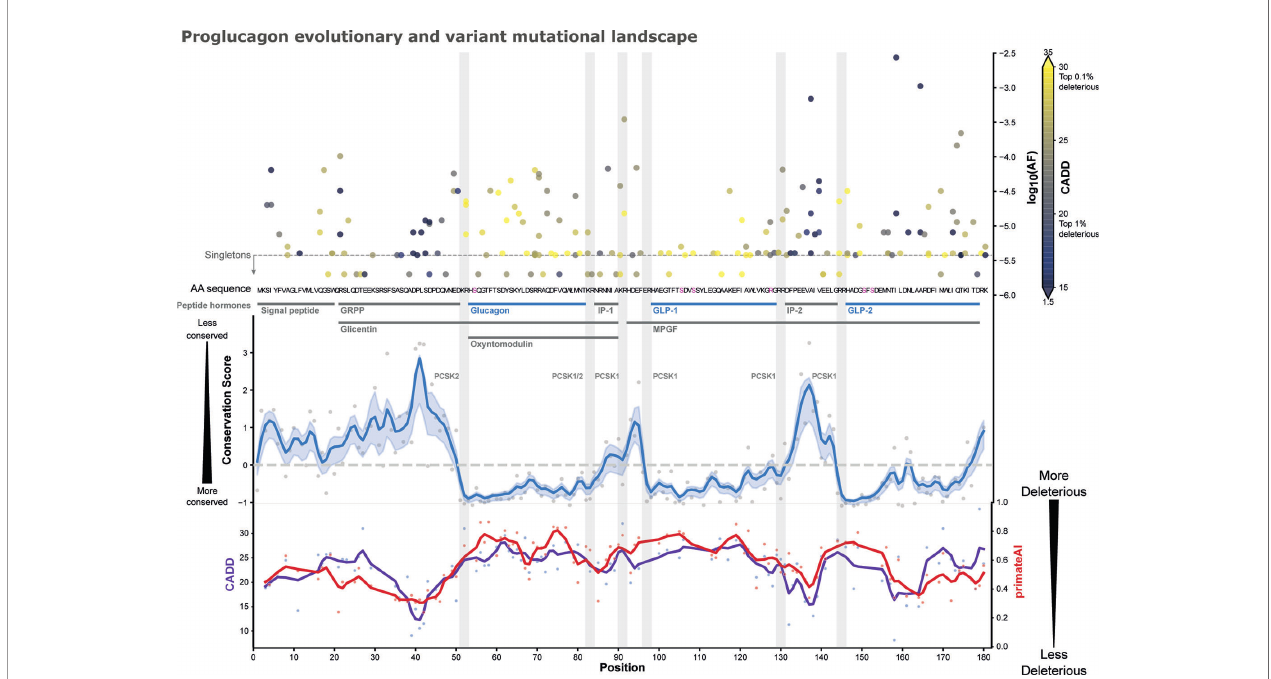
FIGURE 2 | Proglucagon mutational landscape. Functionally described peptide hormones are highlighted ( blue) , which are more conserved in an evolutionary trace analysis employing Rate4Site scores [blue line, gaussian CI: 50% (46, 47)], than other parts of the precursor and peptides such as IP1/IP2, GRPP, and the signal peptide (most conserved position has a score of – 1). All 184 missense variants are displayed along their predicted CADD scores ( color-grading ) (48) and their corresponding max allele frequencies ( top-right y-axis ). Peptide cleavage motifs are highlighted as grey bars alongside their known enzymes. Post-translational modi fi cation sites are highlighted ( pink ) in the amino acid sequence. Predicted CADD ( purple ) and primateAI ( red ) scores are presented ( bottom curves ) (48, 49), indicating higher mean predicted deleteriousness in glucagon and GLP-1. See SF1 for an interactive